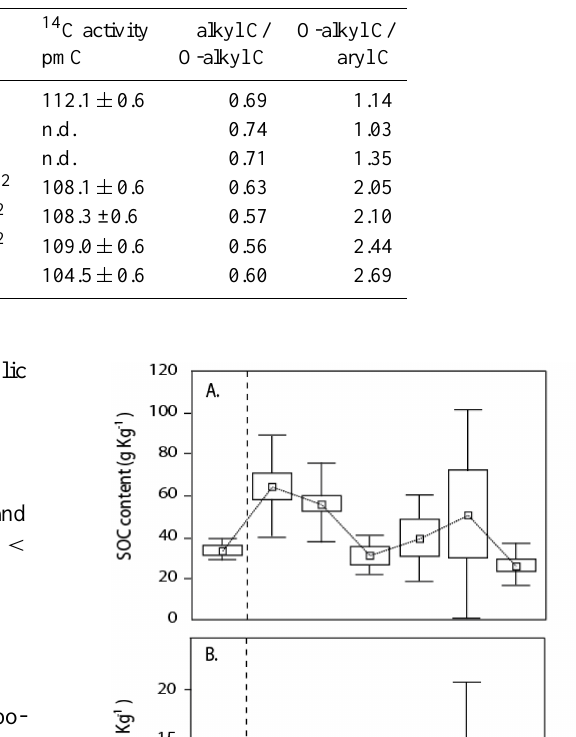
Table 1. 14 C activity and ratios of chemical groups as seen by 13 C CPMAS NMR spectroscopy determined for soil and eroded sediments at different scales.